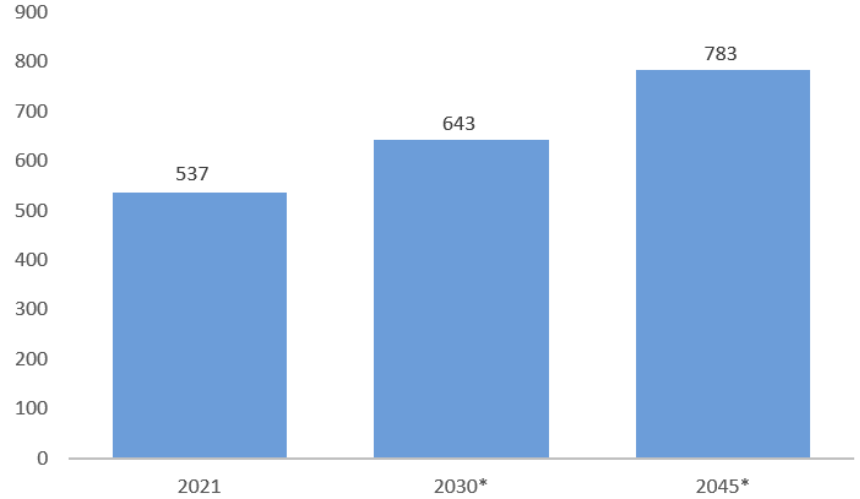
Figure 1. Estimated number of diabetics worldwide in 2021, 2030, and 2045 (in millions). (*) Forecasts. Source: Statista [12].